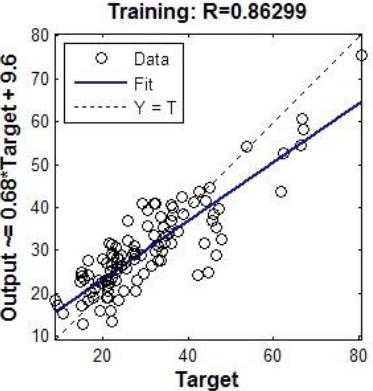
Fig. 11. Relationship between Target and Output Values in Training Step of ANN Modeling with 8 Hidden Neurons.